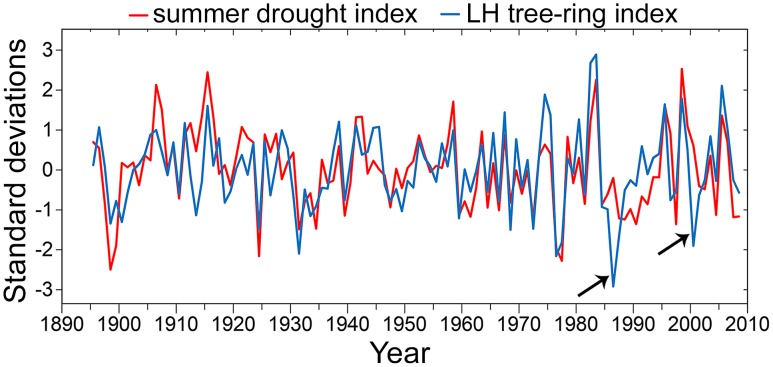
Visual comparison of southernmost Sequoia sempervirens (LH) tree-ring index and Central Coast California summer drought index.Summer drought is average June through September PDSI from the National Climatic Data Center for CA04 (Central Coast California). Both indices standardized by their standard deviates. Note discrepancies after known forest fires in 1985 and 1999 (arrows).